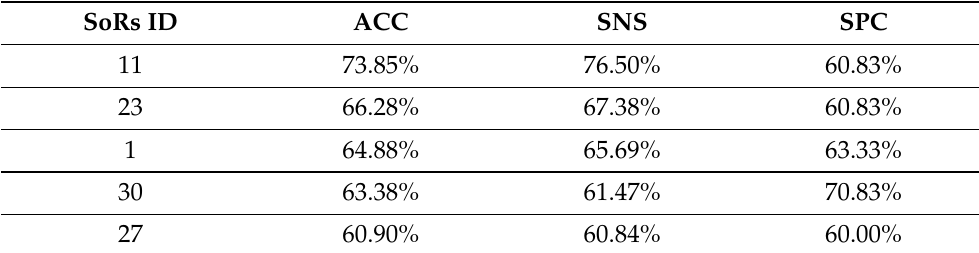
Table 9. SoRs above the required threshold.